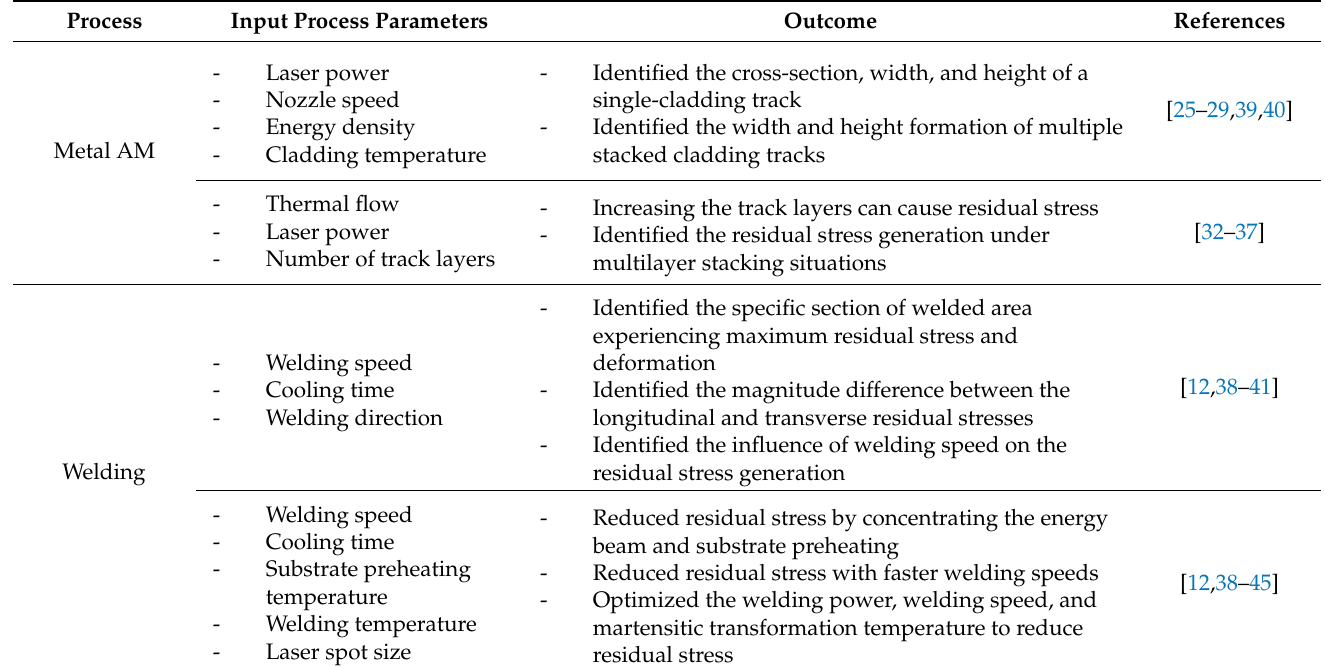
Table 1. Summary of numerical quality control studies of metal AM and welding.